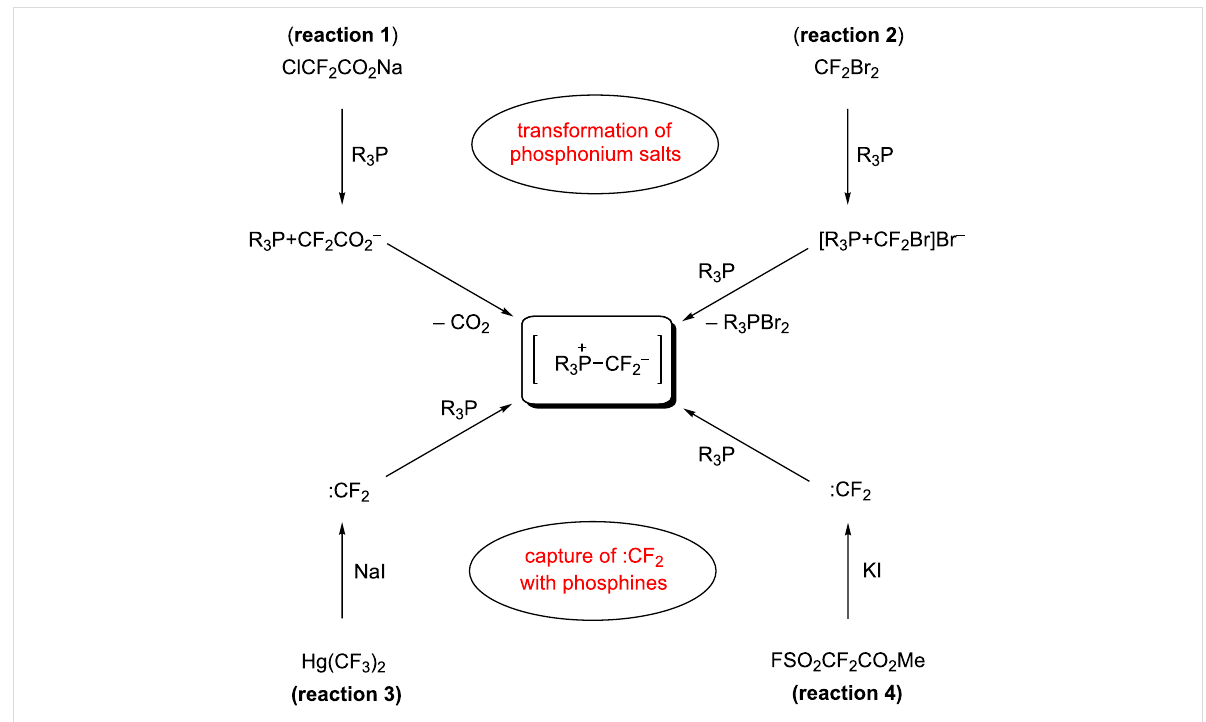
Scheme 1: Various procedures for the generation of difluoromethylene phosphonium ylide